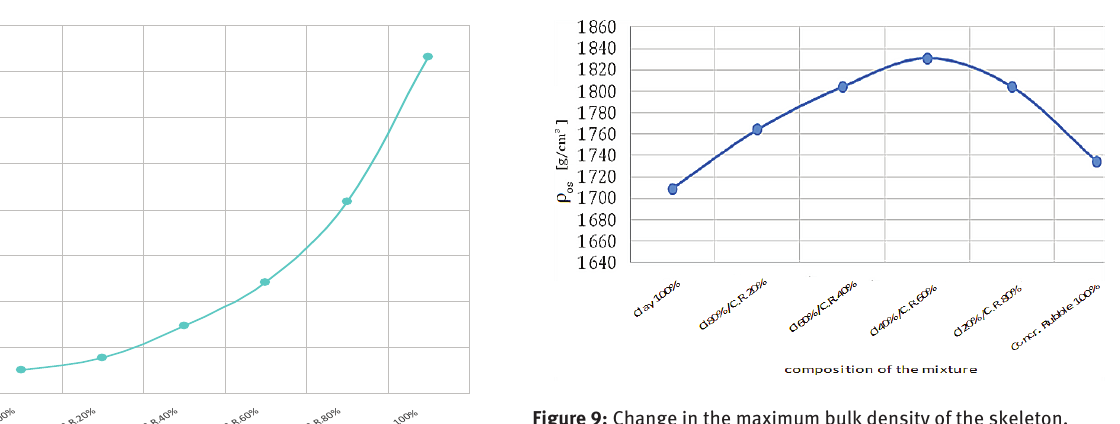
Figure 9: Change in the maximum bulk density of the skeleton, depending on the composition of the